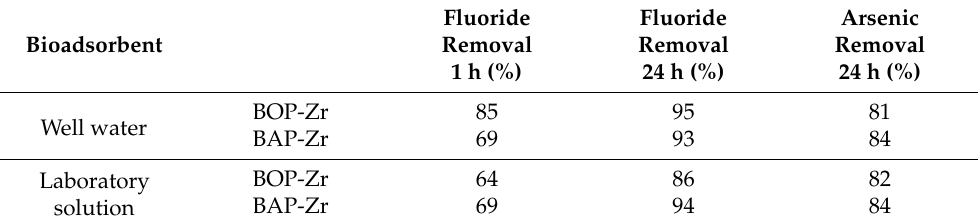
Table 3. Removal percentages of fluoride (after 1 and 24 h) and arsenic (after 24 h) were achieved in well water and laboratory solution by BOP-Zr (C f = 0.58 mg/L) and BAP-Zr (C f = 1.20 mg/L).